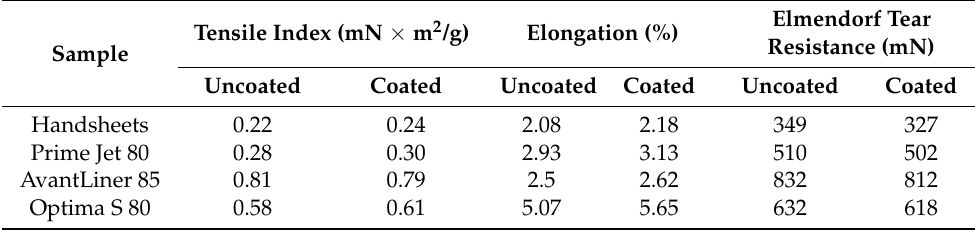
Table 4. Mechanical properties of tested papers.